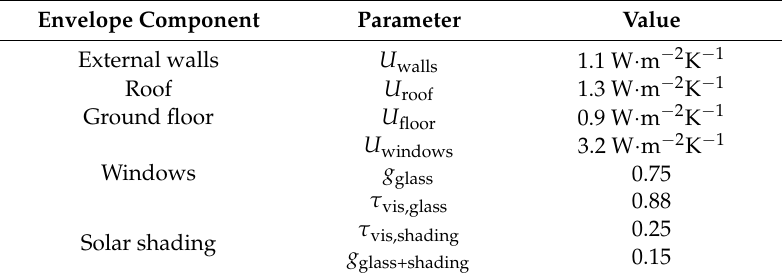
Table 2. Physical data of the existing building envelope